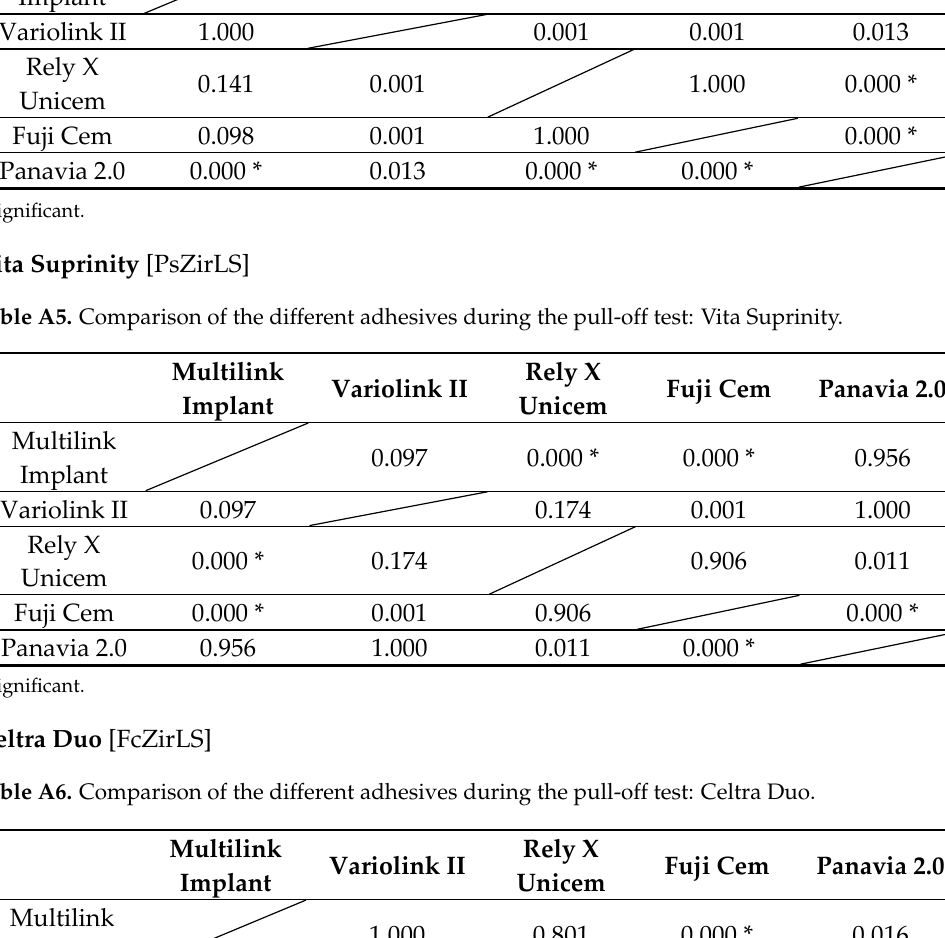
Table A5. Comparison of the different adhesives during the pull-off test: Vita Suprinity.